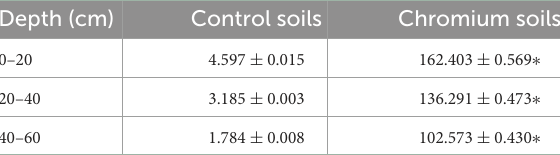
TABLE 2 The contents of Cr (mg/L) in different groups.